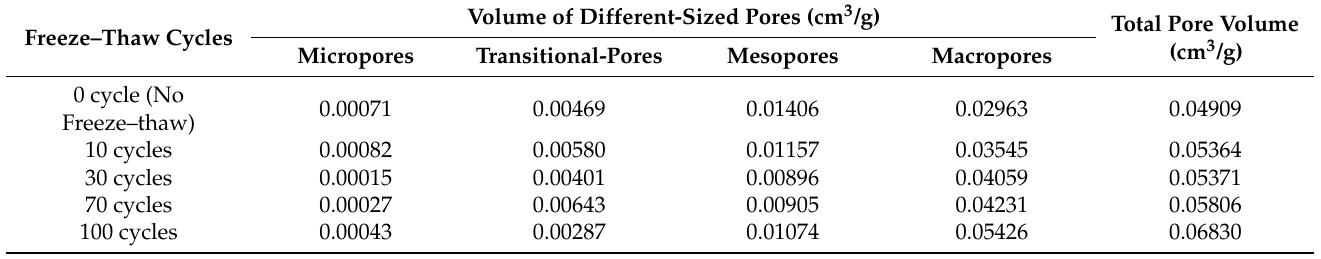
Table 1. Pore volume parameters of red sandstone.